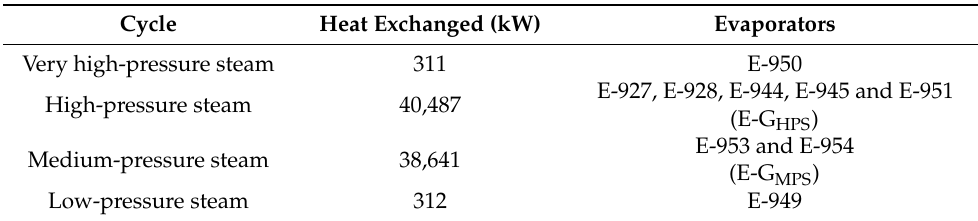
Table 9. Inputs of the